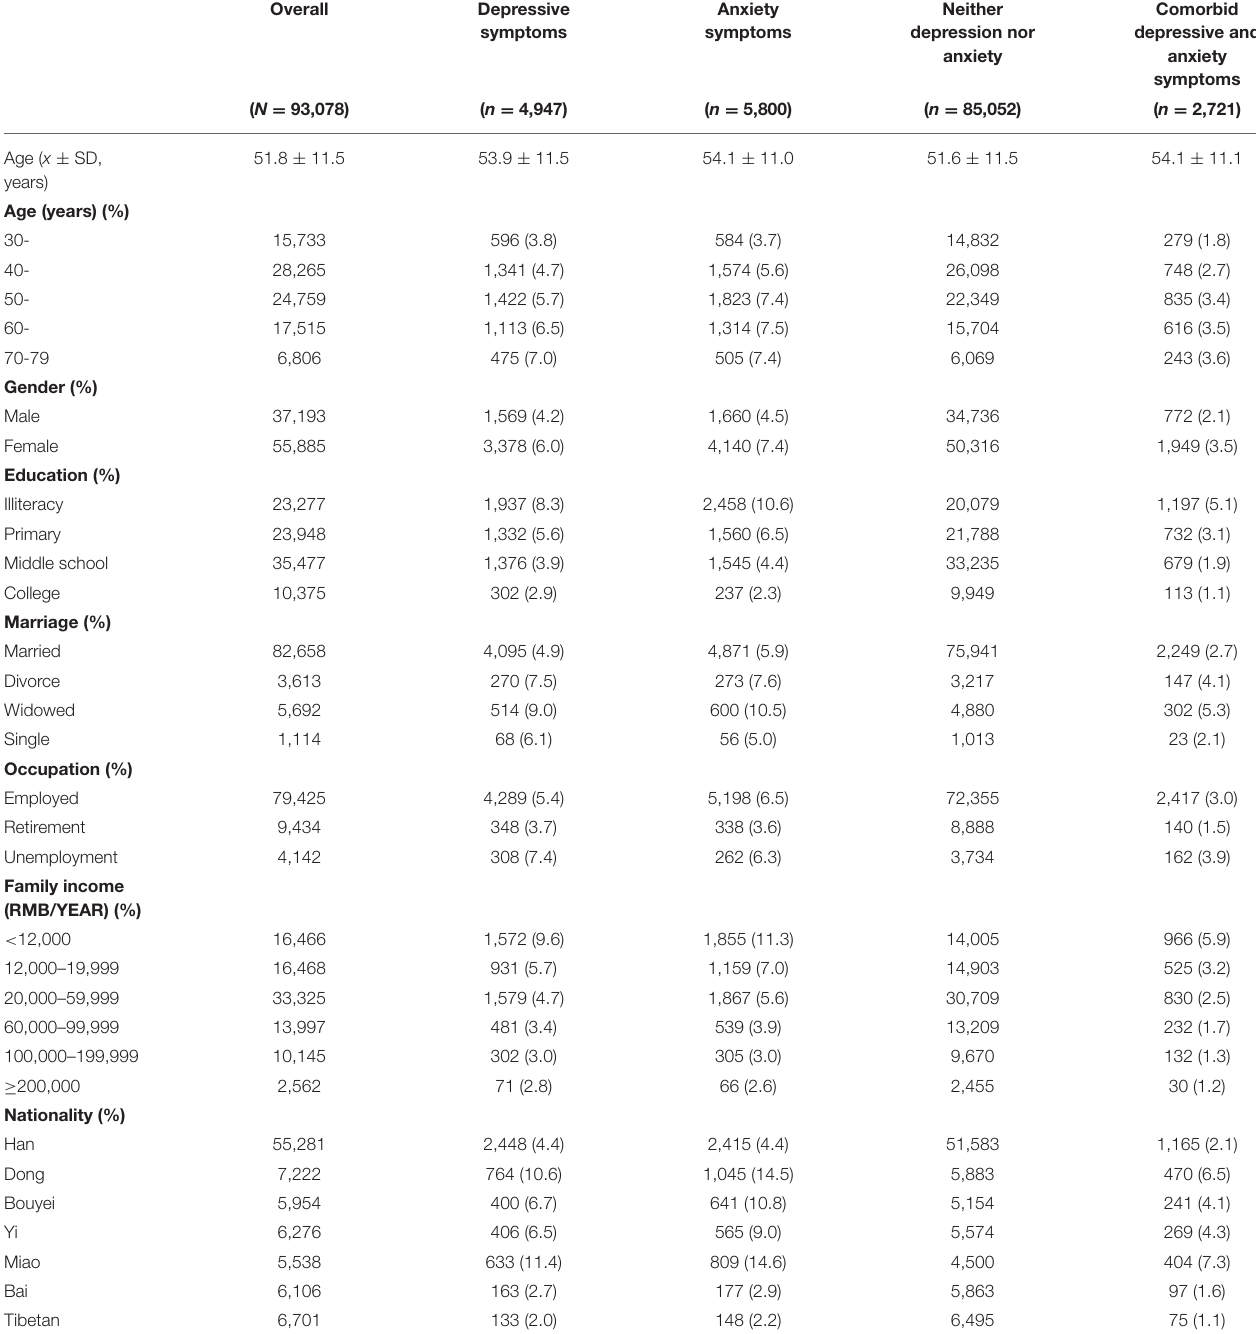
Overall Depressive